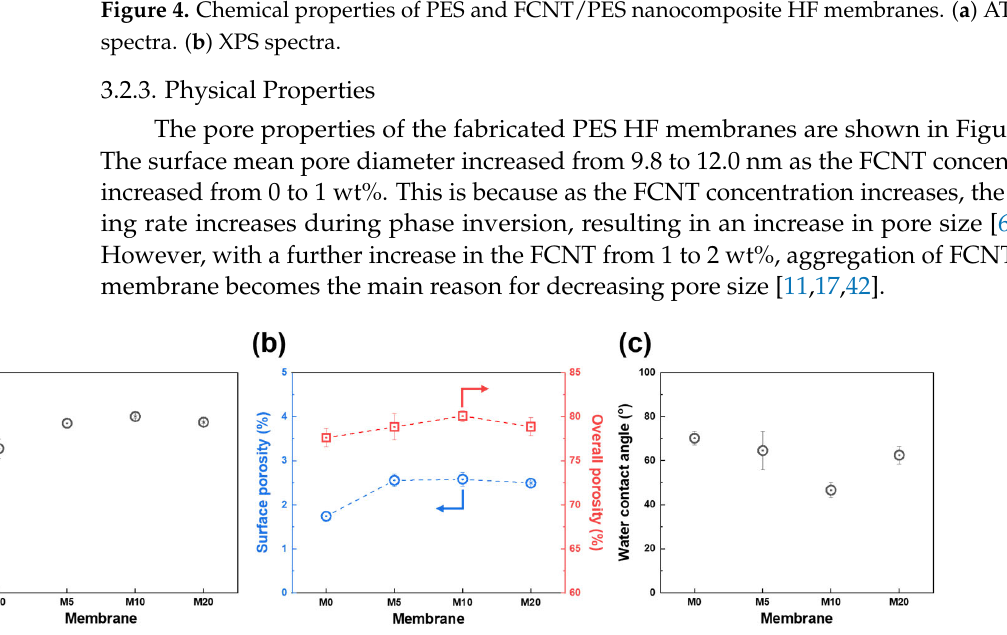
Figure 5. Physical properties of PES and FCNT/PES nanocomposite HF membranes. ( a ) Mean pore diameter. ( b ) Surface (blue) and overall (red) porosity. ( c ) Water contact angle.